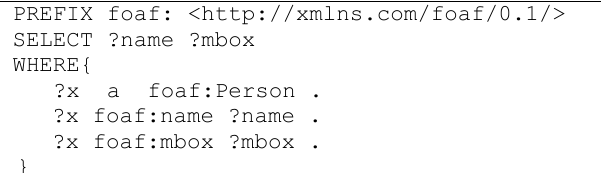
Figure 2. Example of RDF link SPARQL